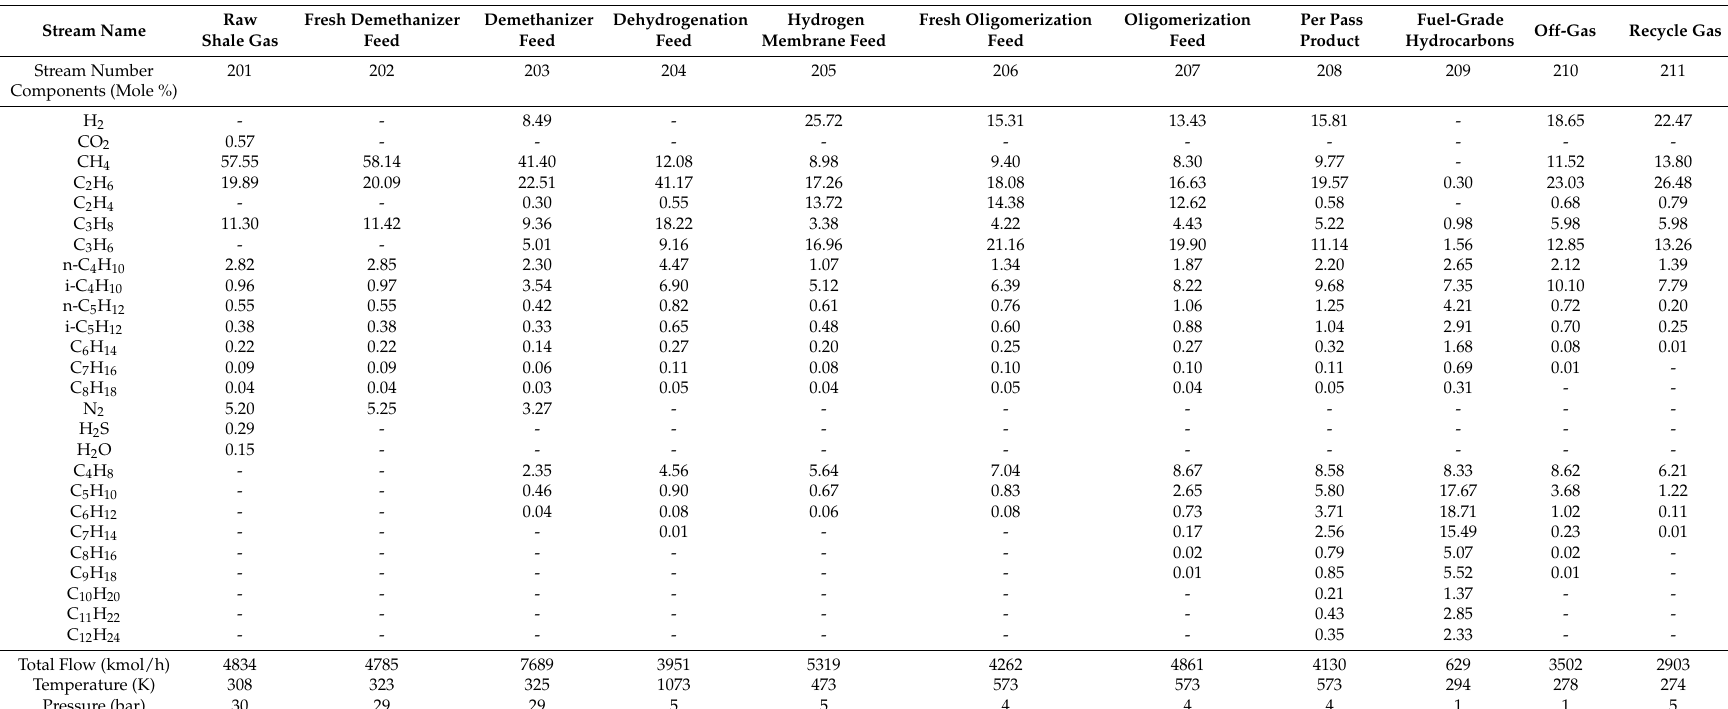
Table 3. Key stream data for Process